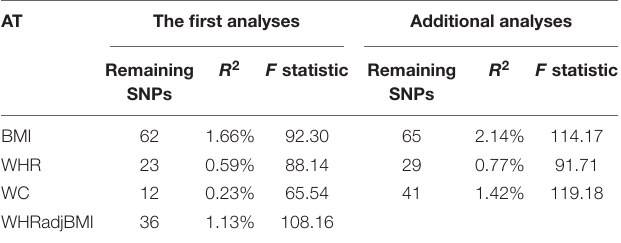
TABLE 2 | The validation of instrumental variables.